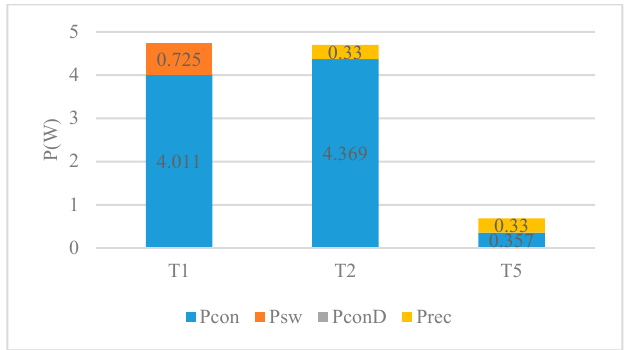
Figure 8. Loss distribution of T1, T2, and T5 in SiC-only topology.